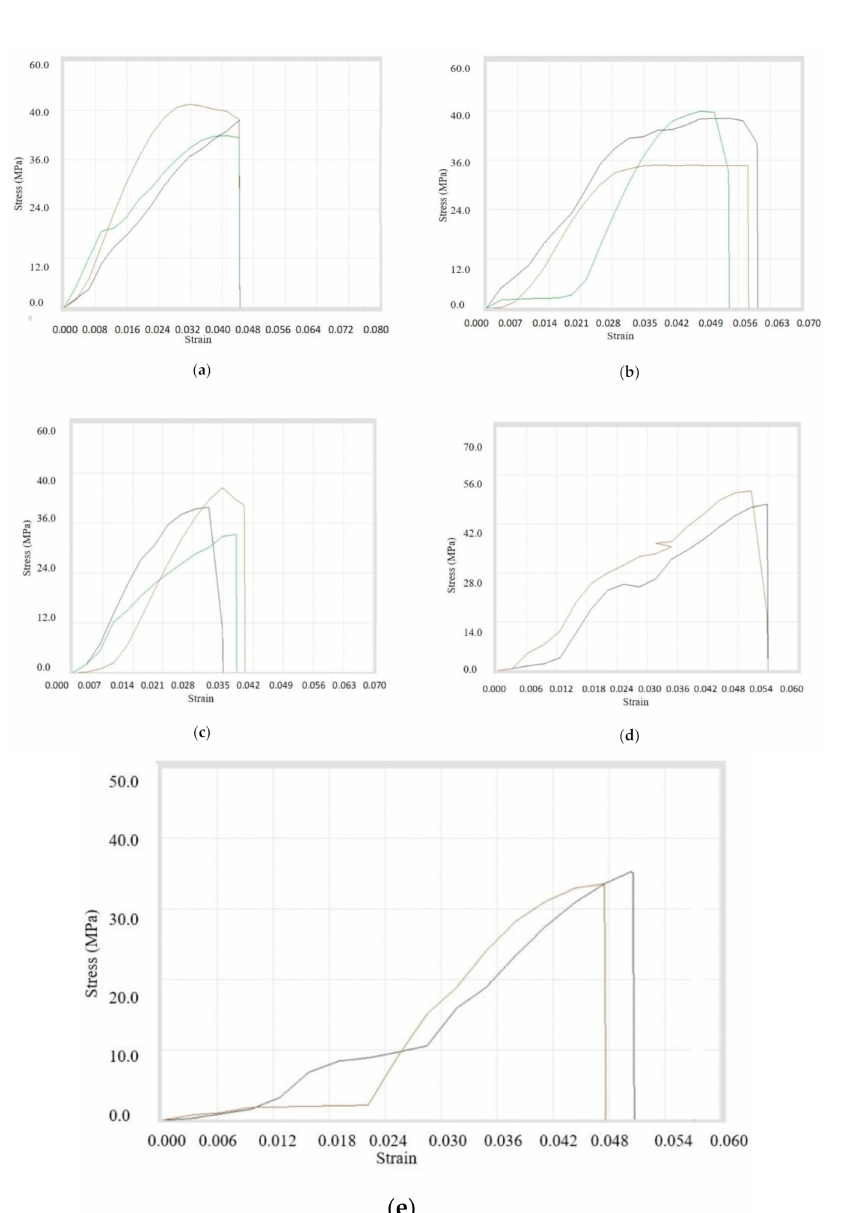
Figure 9. Stress–strain curves for ( a ) B4 , ( b ) B9 , ( c ) B10 , ( d ) B7 , and ( e ) B8 composite